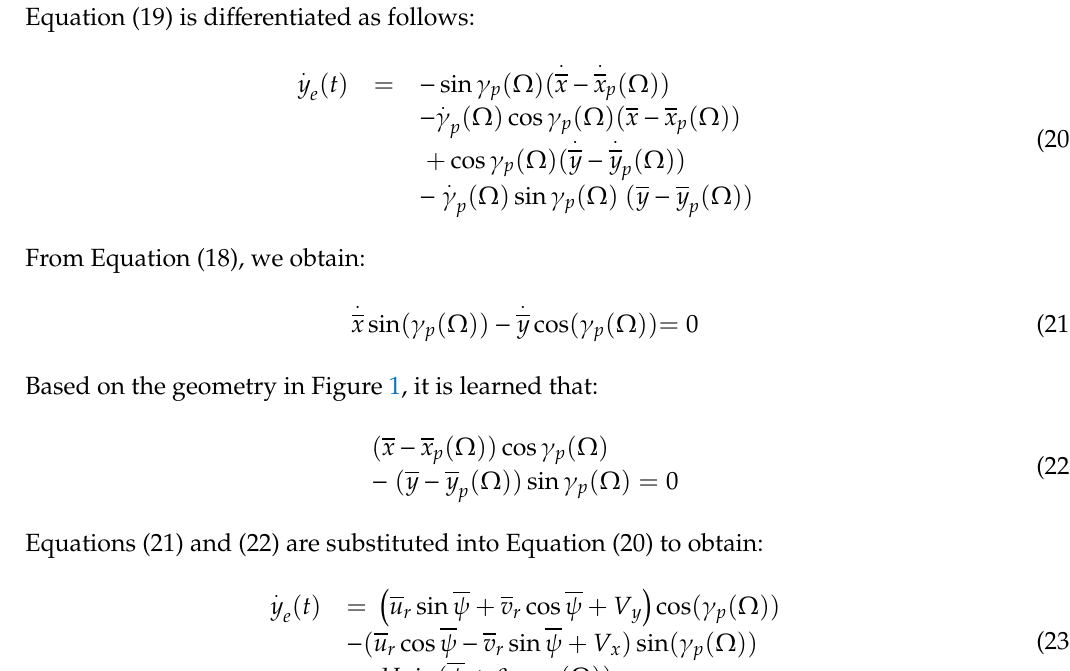
Figure 2. Line-of-sight guidance strategy.